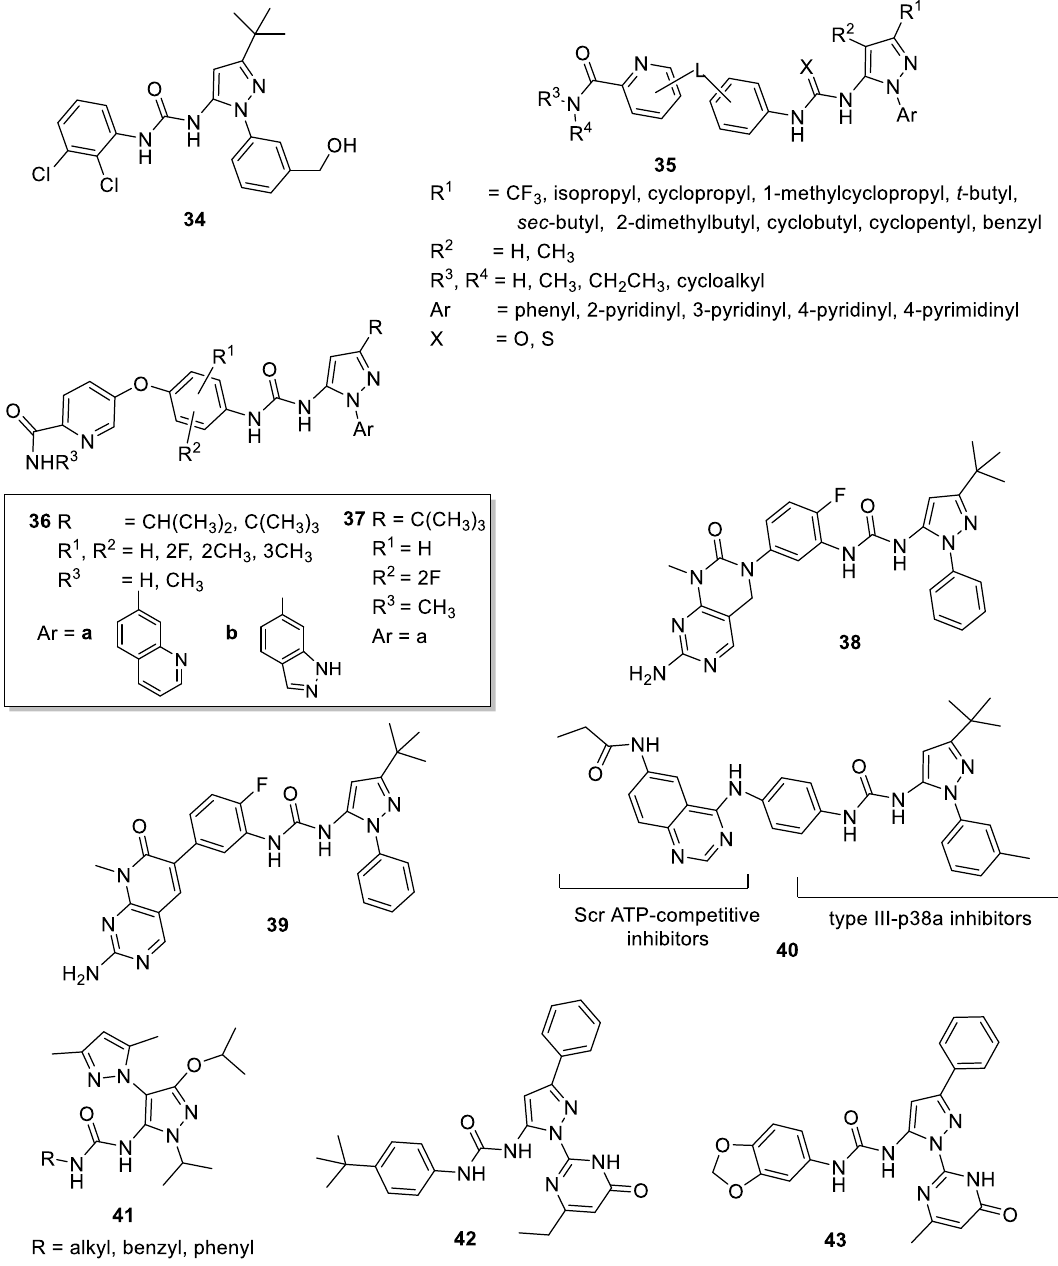
Figure 6. 5-Pyrazolyl-ureas reported as anticancer agents.